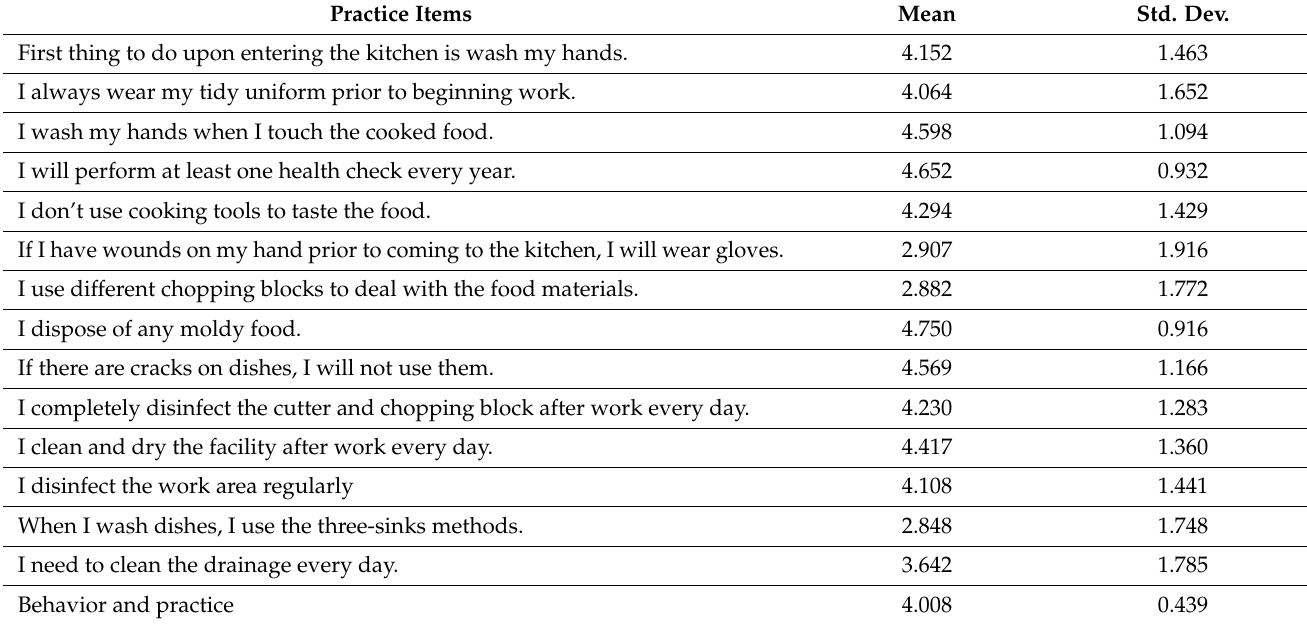
Table 7. Behavior and practice of food handlers in Kenyan high school kitchens. Practice